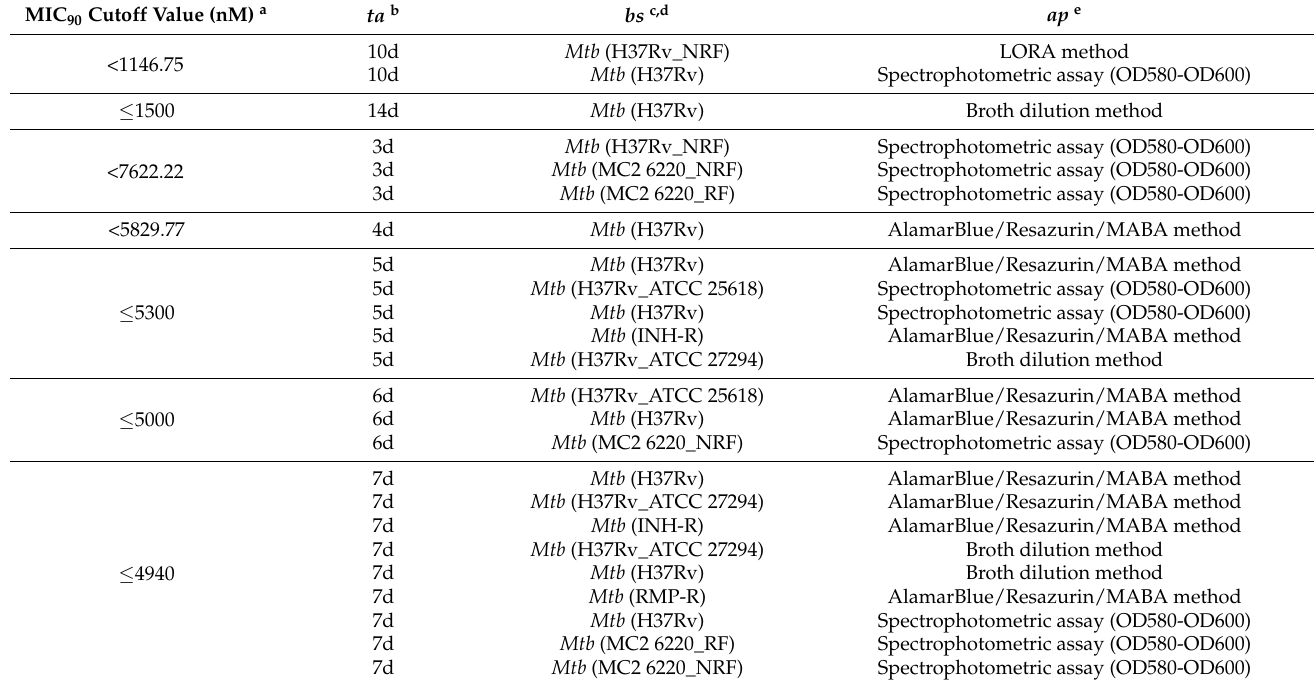
Table 6. Experimental conditions cj (combinations of the elements ta , bs , and ap ) reported in the present work. MIC 90 Cutoff Value (nM)